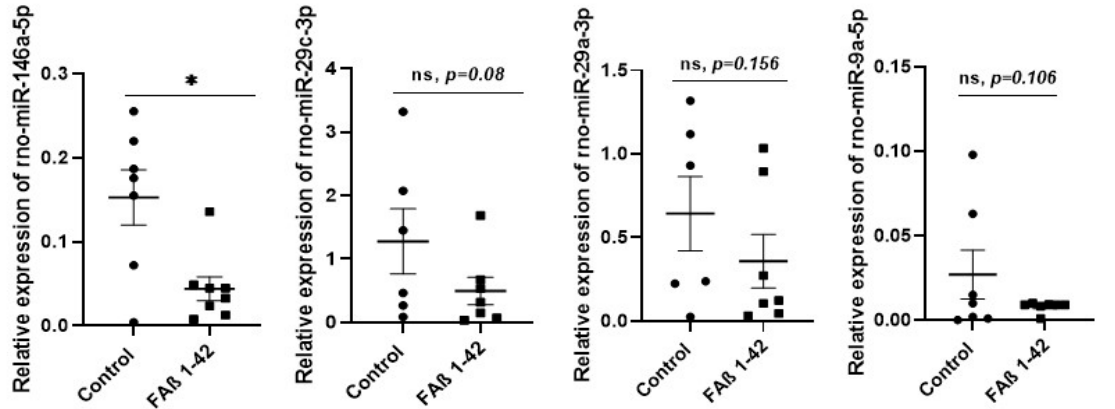
Figure 3. Relative expression of circulating miRNA-146a-5p, miRNA-29a-3p, miRNA-9a-5p, miRNA-29c-3p in serum samples of rats infused with 1 µg/µL of FA β 1-42 peptides solution. Sera from rats infused with FA β 1-42 peptides (treated group) or PBS (control group) solutions were collected 21 days post-infusion. MiRNA were extracted and quantified by qRT-PCR. Data are represented as mean ± SEM of 7–8 samples evaluated in triplicate. Statistical comparisons between FA β 1-42 and PBS group were performed using the Mann–Whitney test * p ≤ 0.05.